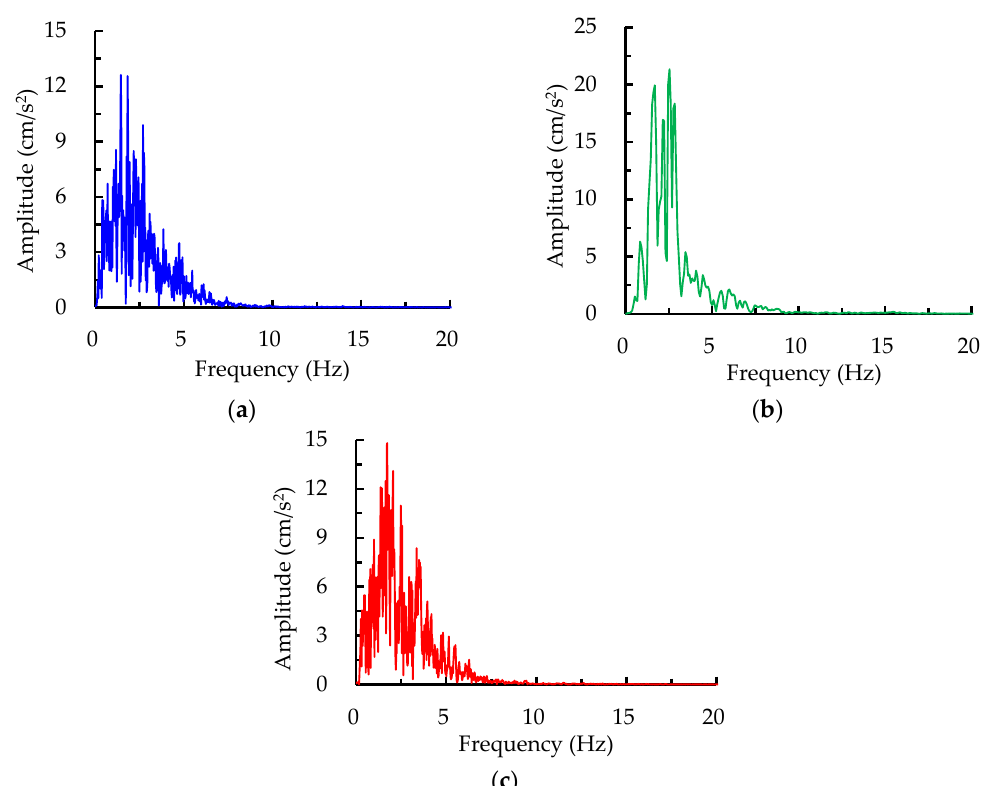
Figure 15. Corresponding frequency spectra of waves. ( a ) El Centro wave; ( b ) Kobe wave; ( c ) Taft wave.